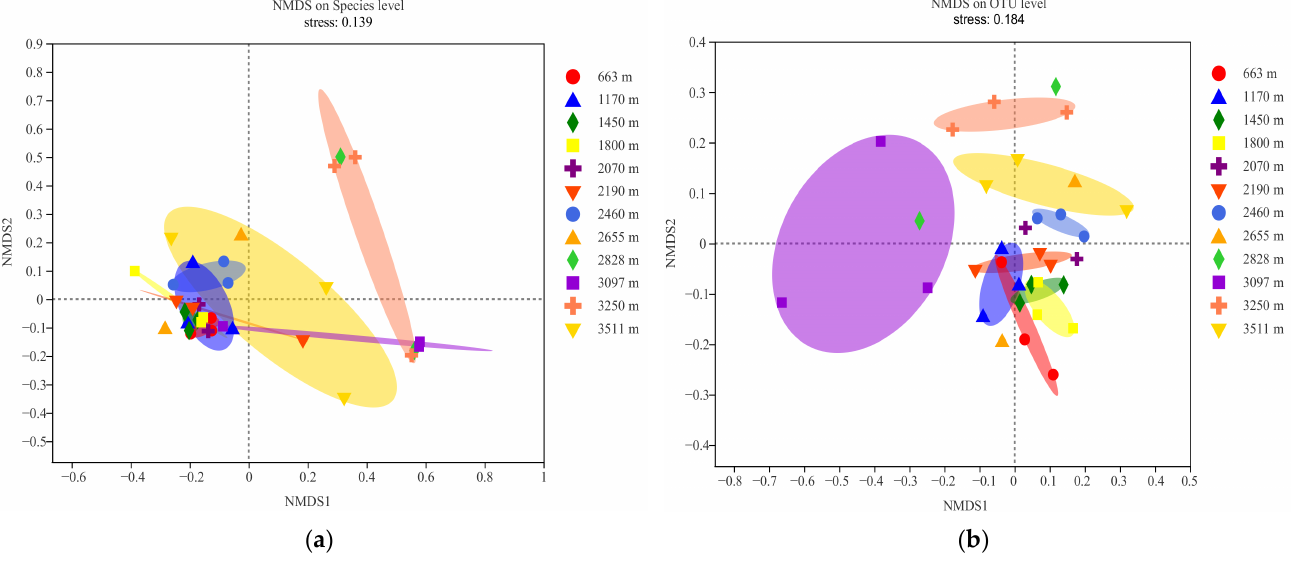
Table 1. Relative abundance and occurrence frequency of AMF genus in Mt. Taibai.